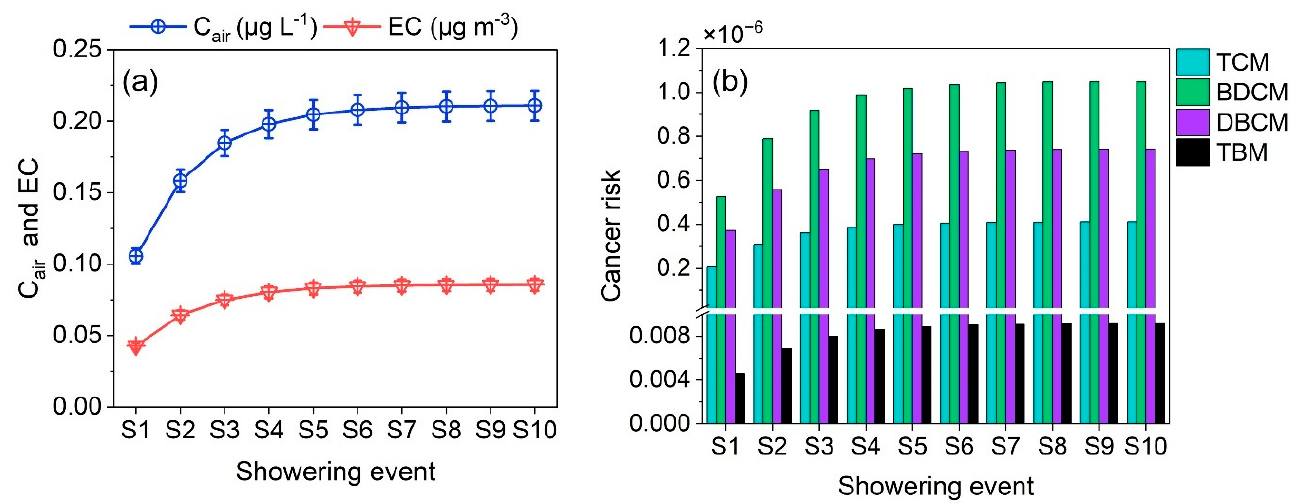
Figure 5. Incremental effect of continuous showering events in common washrooms. ( a ) Increase in total THM concentration in the shower room air (C air ) and exposure concentration (EC); ( b ) total inhalation risk through continuous showering events. TCM: trichloromethane, BDCM: bromodichloromethane, DBCM: dibromochloromethane, TBM: tribromomethane, and S1–S10: shower event 1 to 10.